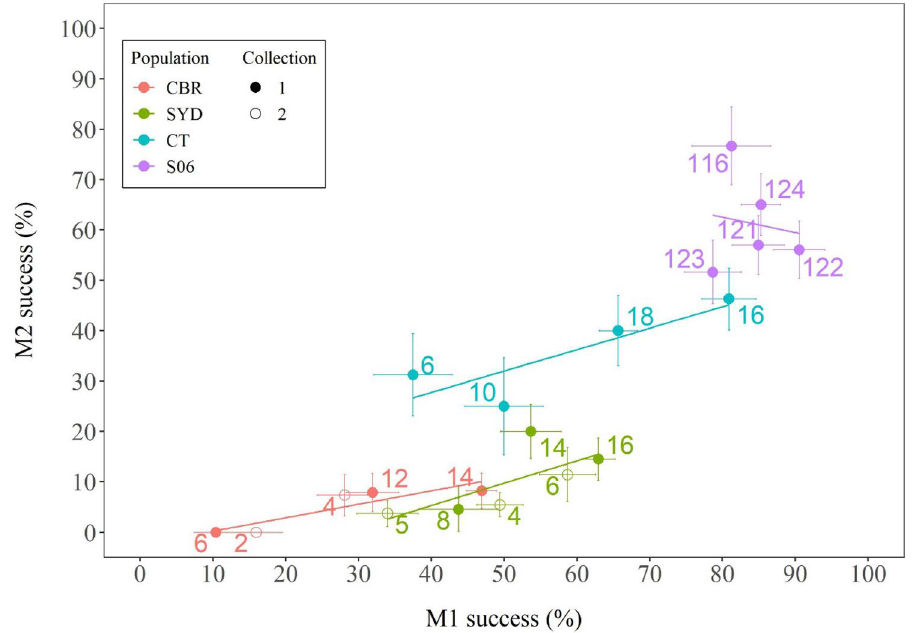
Figure 3. The correlation between M1% and M2% across all source population-generation combinations in Experiment 1. Data are taken from Fig. 2 with populations shown in different colours. The data for the -1 and -2 collections of CBR and SYD are shown with filled and open symbols respectively and generations are indicated by the numbers adjacent each symbol. Lines of best fit are shown for each